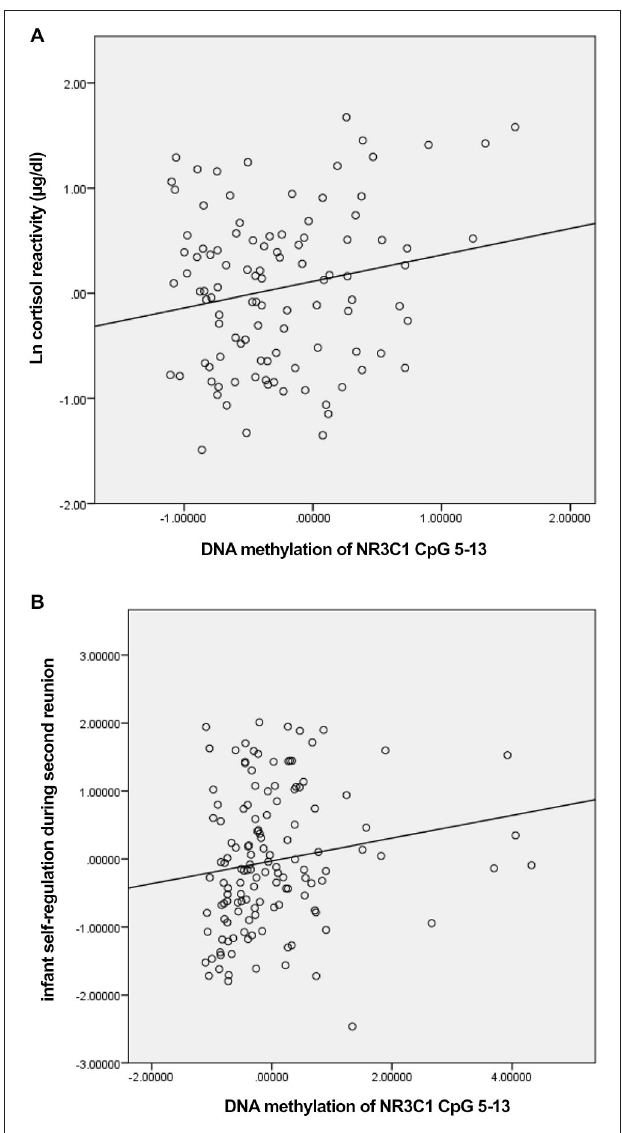
FIGURE 1 | Scatterplots for the correlation between DNA methylation of NR3C1 CpG 5–13 factor score and cortisol reactivity (A) and infant self-regulation following the second still-face episode (B)